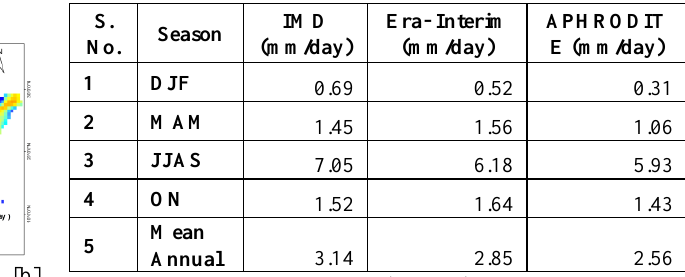
Table 4. Mean seasonal rainfall (mm/day) estimated from Era-